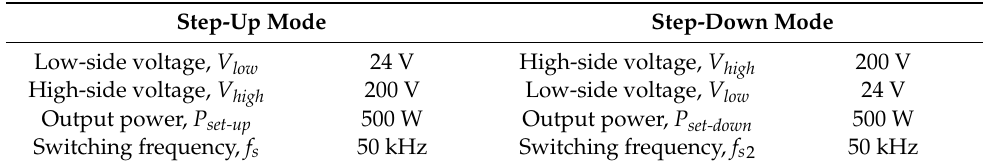
Table 1. Specifications of the experimental system.